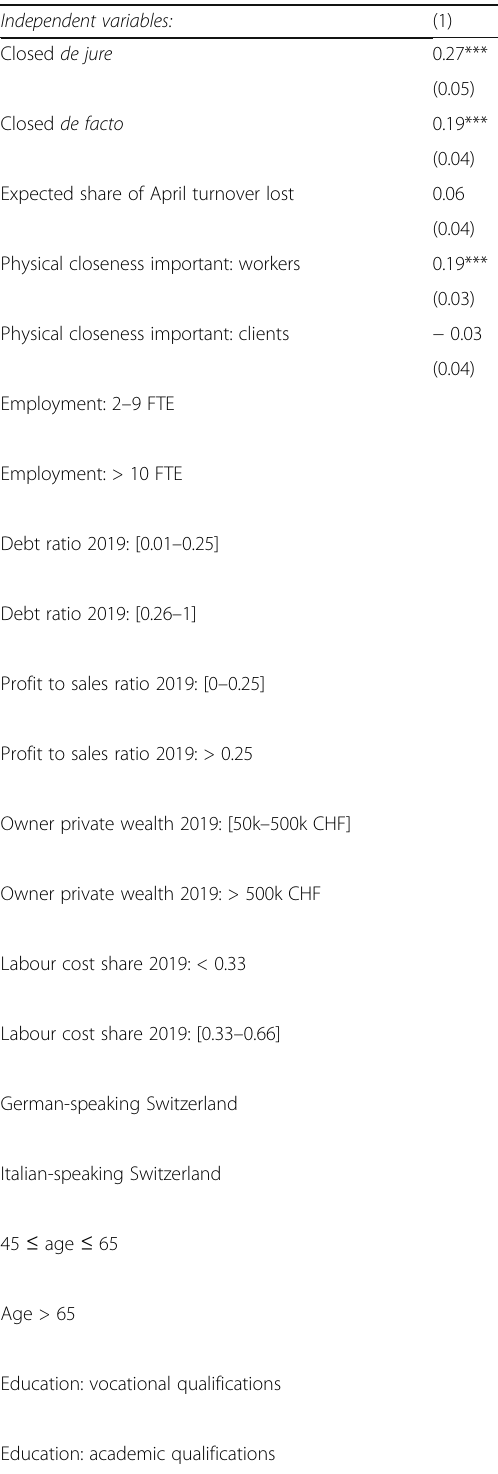
Table 2 Determinants of the use of the short-term